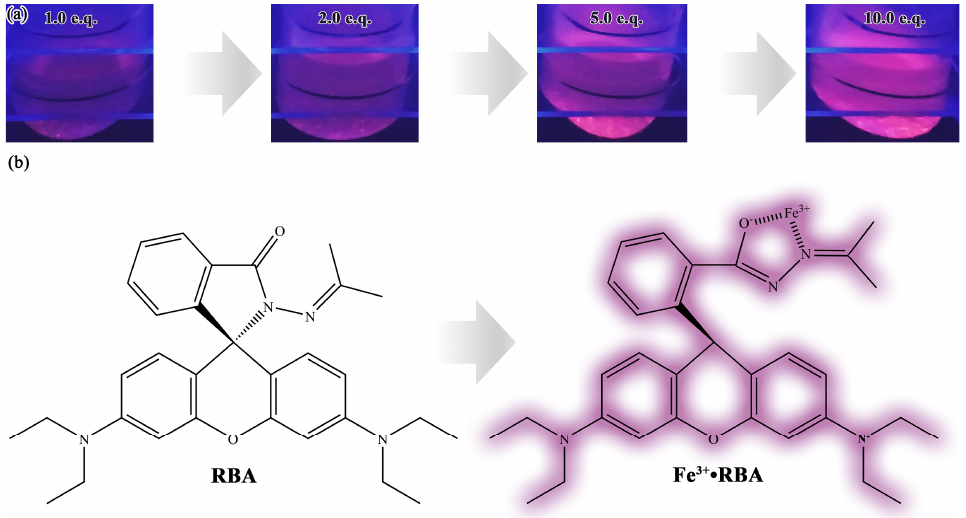
Figure 8. The ( a ) fluorescence photos of RBA in iron ion environments differed in concentrations and ( b ) the complexation reaction mechanism of Fe (cid:2871)(cid:2878) activated fluorescence.